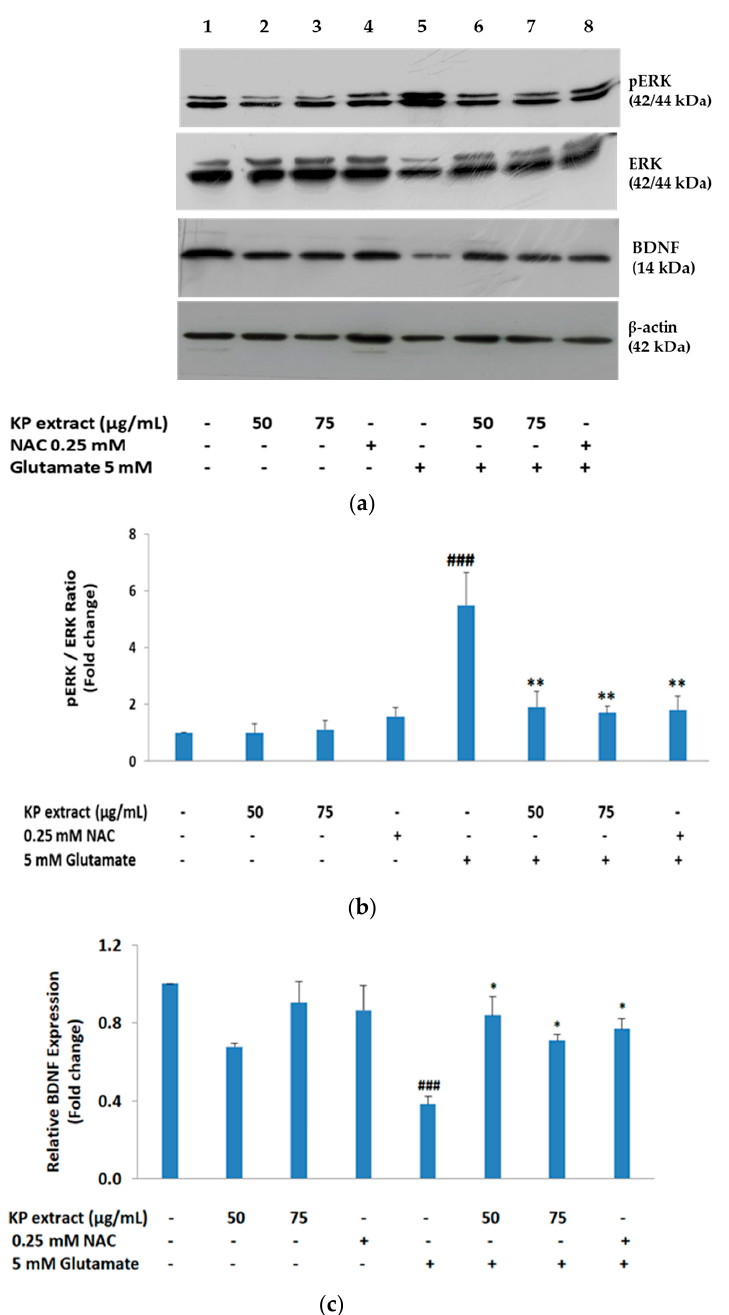
Figure 4. Effect of KP extract on the glutamate-induced phosphorylation of extracellular signal- regulated kinase (ERK) and brain-derived neurotrophic factor (BDNF) expression. ( a ) HT-22 cells were exposed with 50 and 75 μ g/mL KP extract in the presence or absence of glutamate (5 mM) for 14 h, NAC (0.25 mM) was used as positive control. Following incubation, the cells were harvested and BDNF, ERK, and protein kinase-like endoplasmic reticulum kinase (p-ERK) levels were investigated by Western blot analysis. The immunoreactive bands were detected using specific antibodies for BDNF, ERK, p-ERK, and β -actin; ( b , c ) bars represent the fold-increase in phosphorylation of mitogen-activated protein kinases (MAPKs) and BDNF expression, respectively. All data were normalized to internal control levels and are expressed as the mean ± SEM (n = 3), ### p < 0.001 vs. control, * p < 0.05 and ** p < 0.01 vs. glutamate alone . The symbol "-" and "+" are defined as absent and present, respectively.